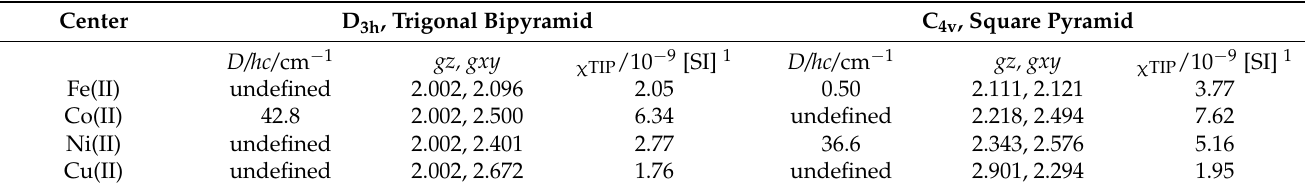
Table 2. Calculated spin Hamiltonian parameters for pentacoordinate